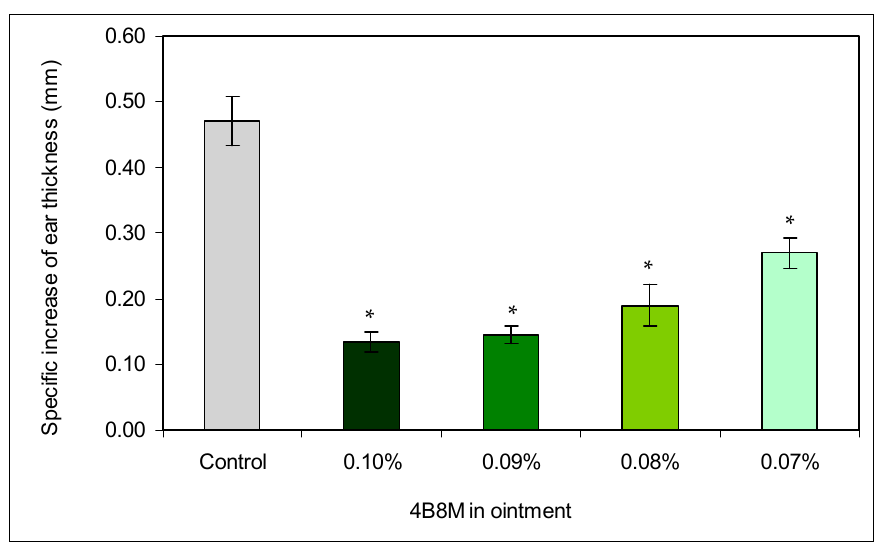
Figure 2. The dose-dependence efficacy of the peptide in inhibition of oxazolone-induced ear edema: the mice were topically sensitized with oxazolone. The reaction was elicited 5 days later by application of oxazolone on both sides of the auricles. BG mice were not sensitized and treated only with the eliciting dose of the antigen. Control: inflamed mice were not treated with the peptide. The peptide, in ointment at a concentration of 0.07–0.1%, was applied on the auricles on each side of the ear 24 h after application of the eliciting dose of oxazolone. The measurement of the ear edema was performed 24 h later, and the results are presented as the antigen-specific increase of the edema (by subtracting BG values). Mean values ± SE for respective groups are presented. * Control vs. 4B8M p < 0.05 (ANOVA).